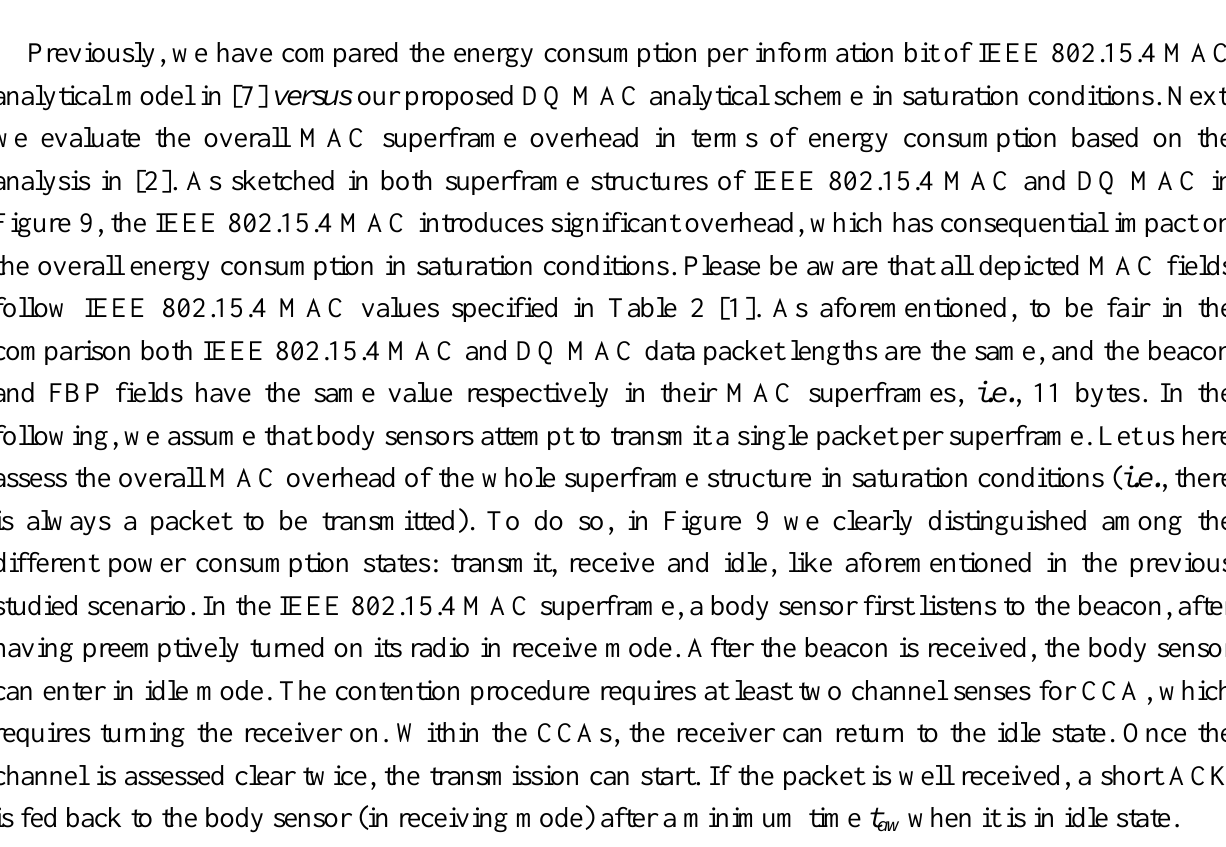
Figure 9. Energy consumption per information bit of DQ MAC protocol for